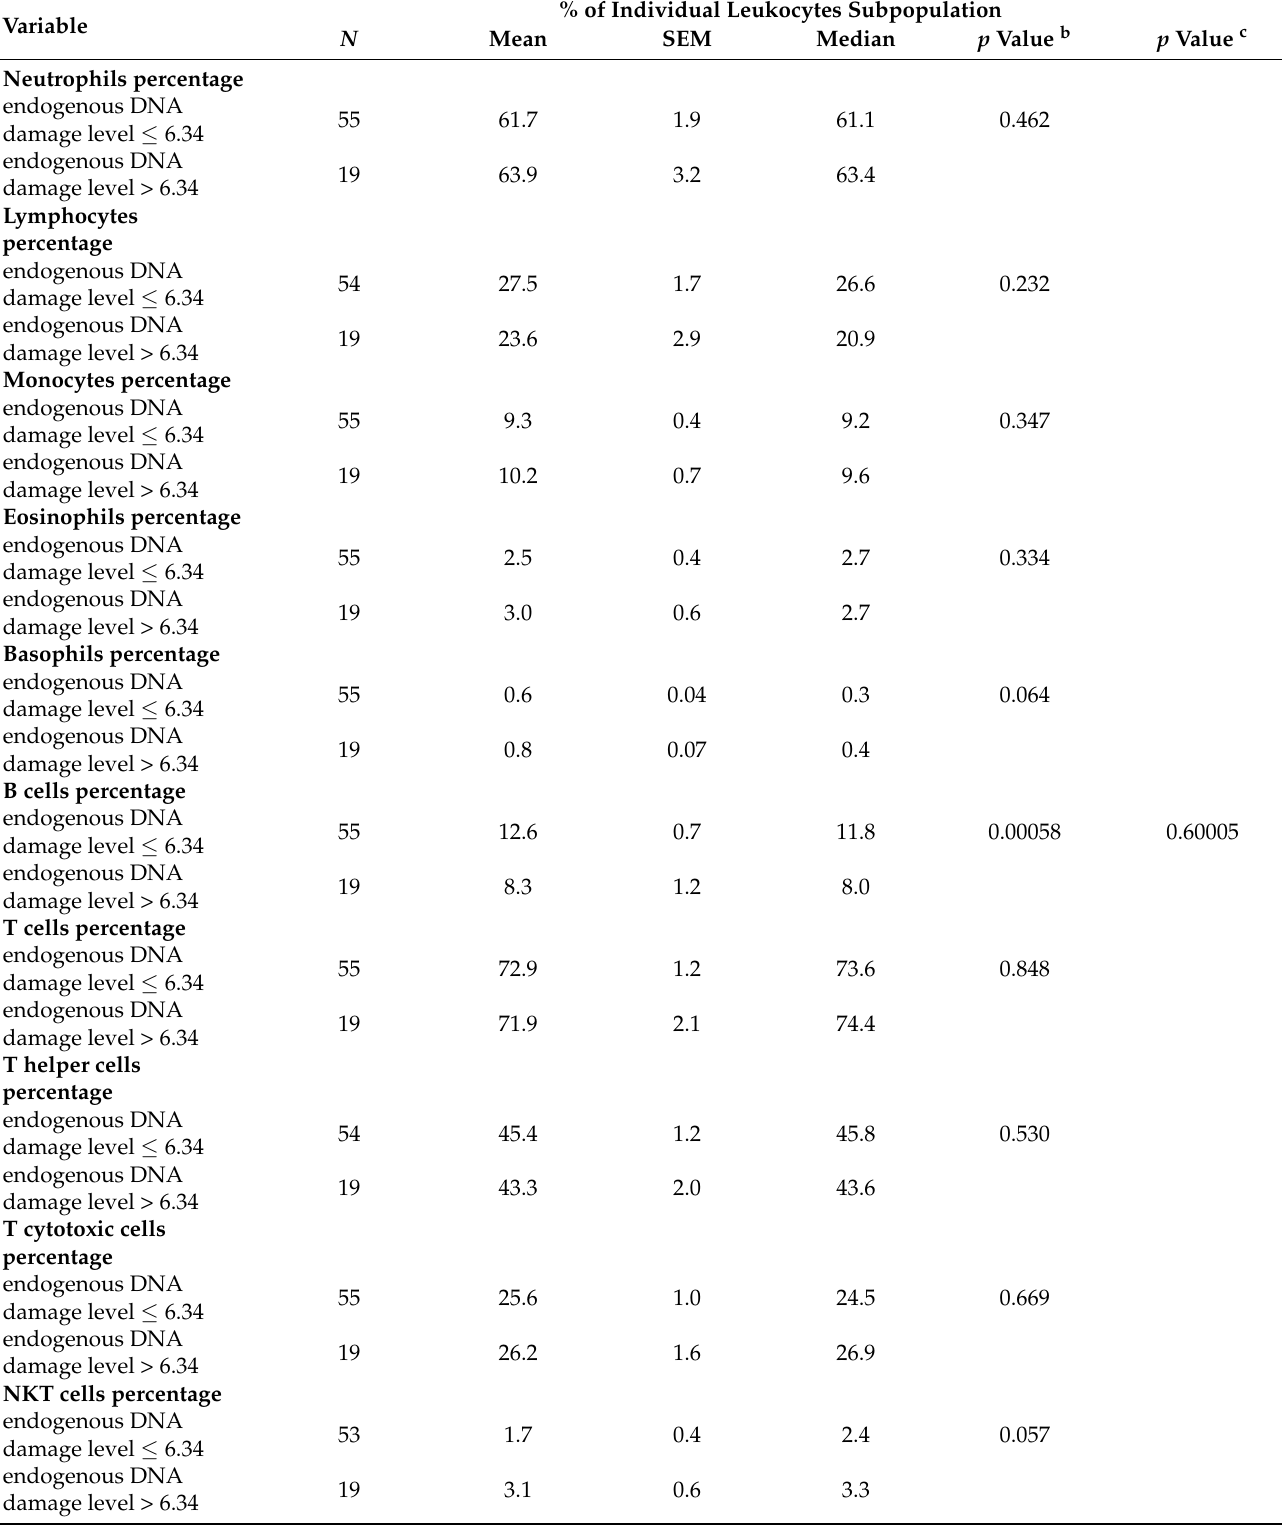
Table 3. Association between the endogenous DNA damage level and percentages of different leukocyte subpopulations in GCT patients. Univariate and multivariate logistic regression analysis was used for statistical evaluation of the obtained